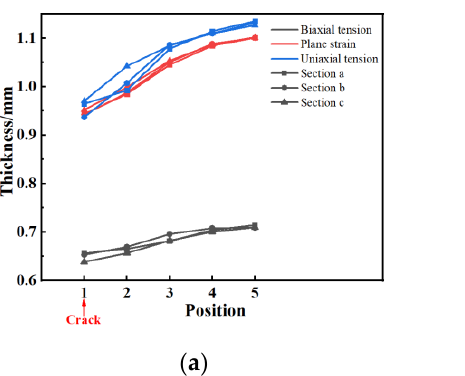
Figure 14. Major strain and strain rate evolution for two independent tests on a 180 mm wide specimen: ( a ) the first test; ( b ) the second test.